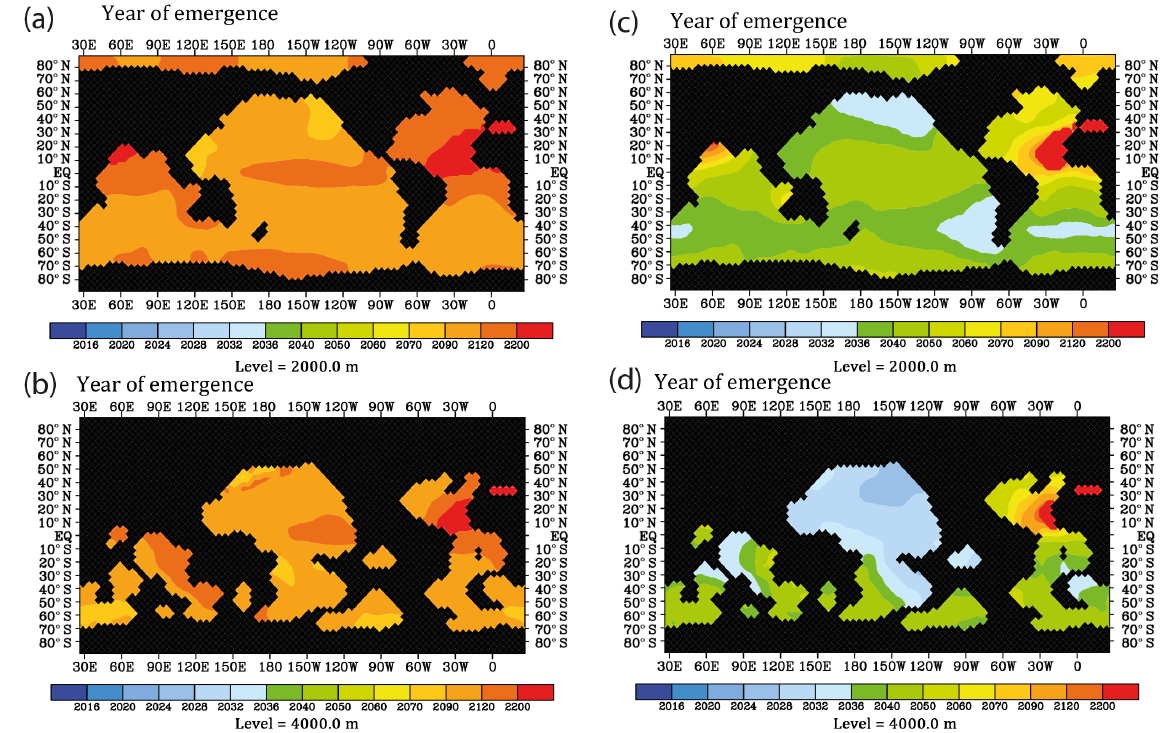
Figure 12. Prospective year of emergence for an ocean-acidification-induced signal in dissolved 230 Th activity as derived from the model runs. Shown are the calendar years of emergence for the depth levels at 2000 and 4000m. All figures are shown for the strong RCP8.5 scenario concerning atmospheric CO 2 concentration and the moderate scenario of calcification decrease with saturation state, with the year 2010 as a reference year for 230 Th activity and 2.5 · 0.075dpm/1000L as analytical threshold between different samples. In contrast to Fig. 11, here, an analysis including interannual/decadal variability in selected biogeochemical parameters is shown. (a) For the moderate calcification scenario, at 2000m depth. (b) Same as panel (a) but for depth level 4000m. (c) For the extreme calcification scenario, at 2000m depth. (d) Same as panel (c) but for depth level